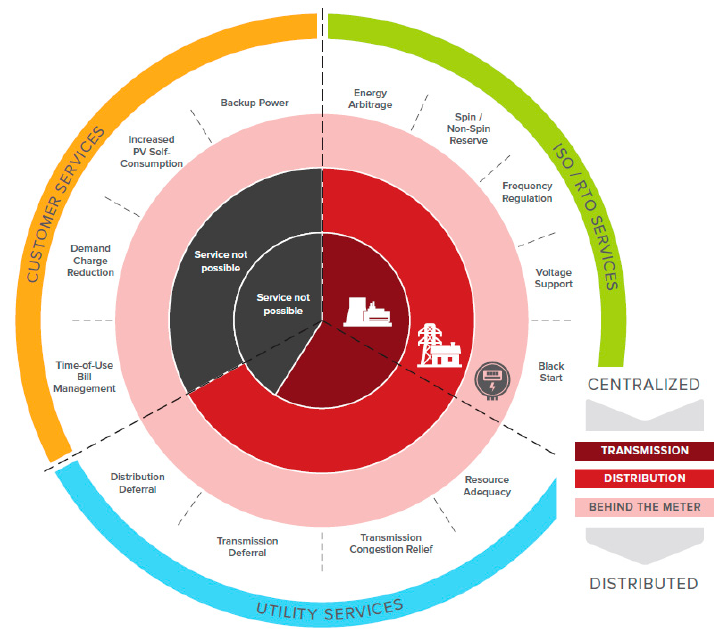
Illustration of 13 services o ff ered by BESS to three main stakeholders: (1) Utility, (2) Customer, (3) Independent System Operator, ISO or Regional Transmission Organizers, RTO. Source: Fitzgerald et al. 2015 [30.]